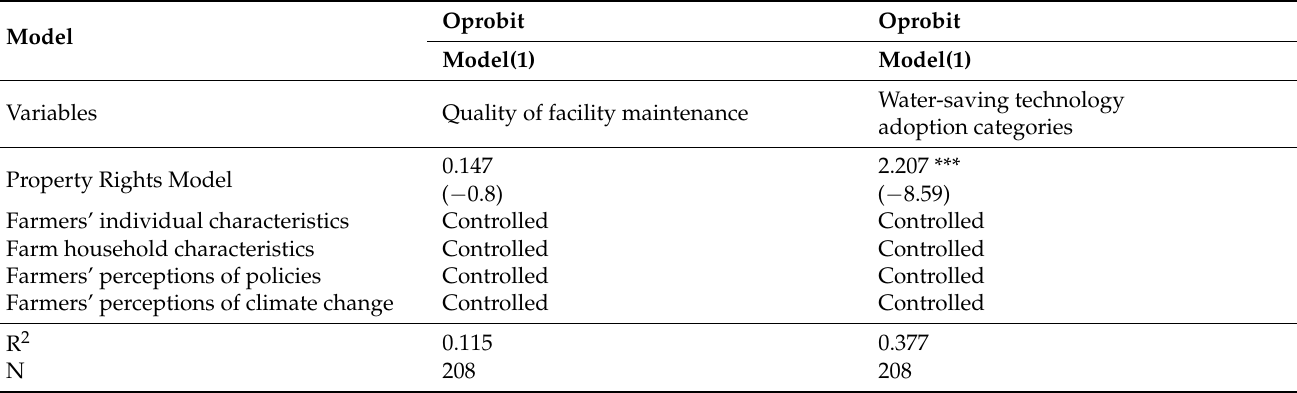
Table 6. Regression results for heterogeneity of ownership